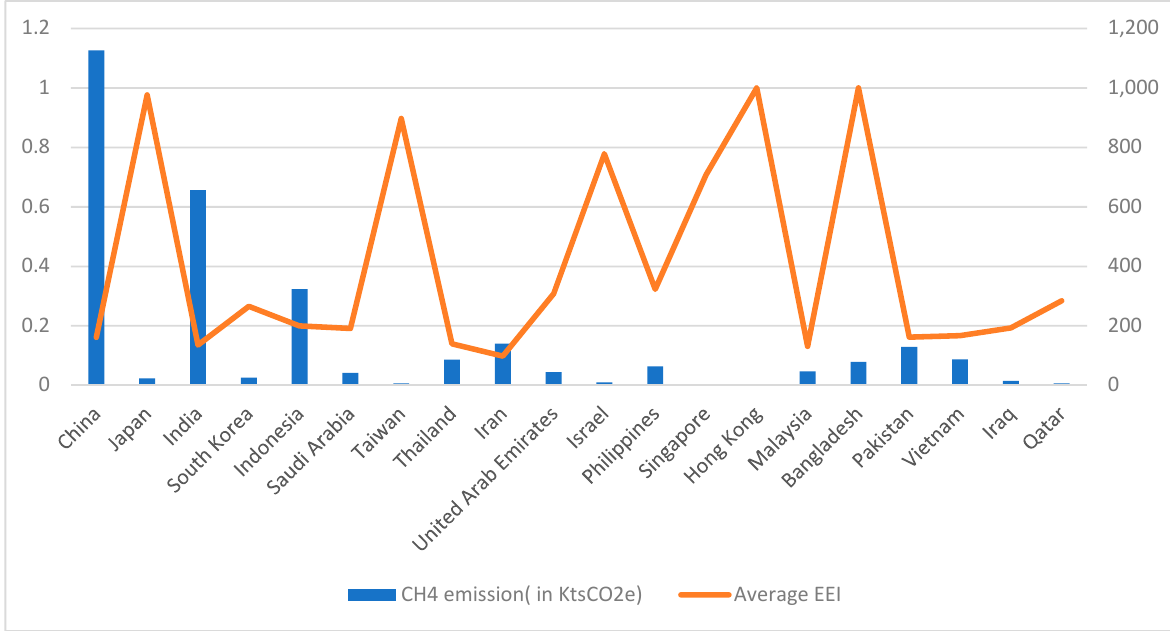
Figure 7. Comparison between the average EEI and the average CH 4 emissions. Source: authors’ estimation.